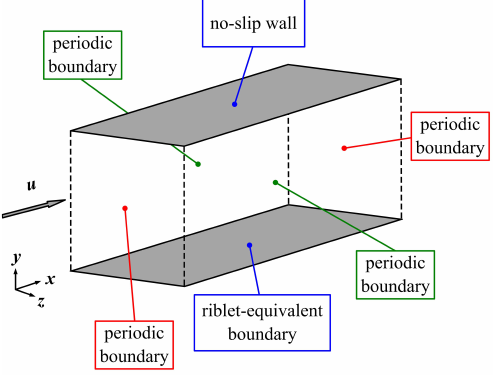
Figure 8. Schematic picture of the channel flow model.